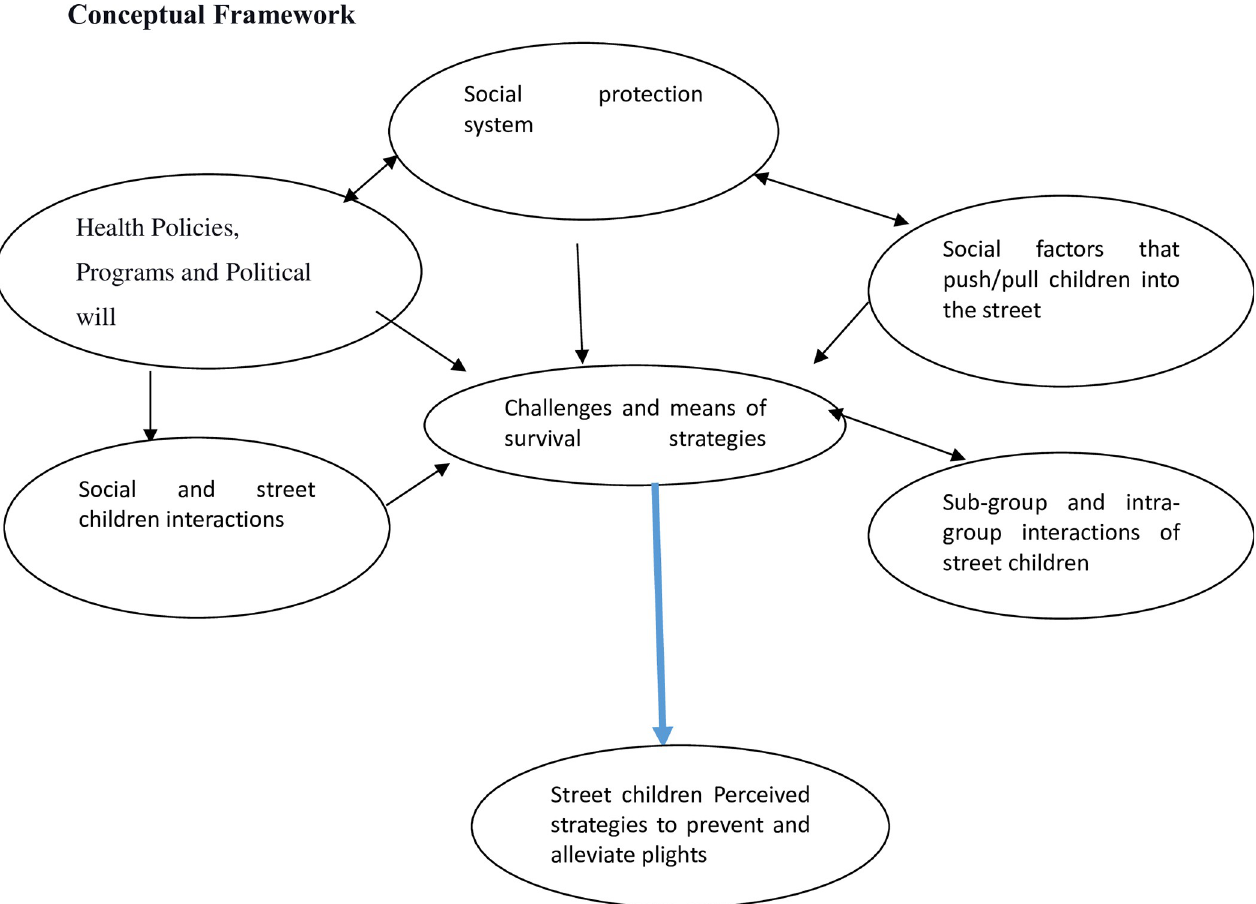
Fig 1. Conceptual framework adopted from Tajfel’s social theory and its application to understanding Metis as a social identity (Jennifer Dawn).